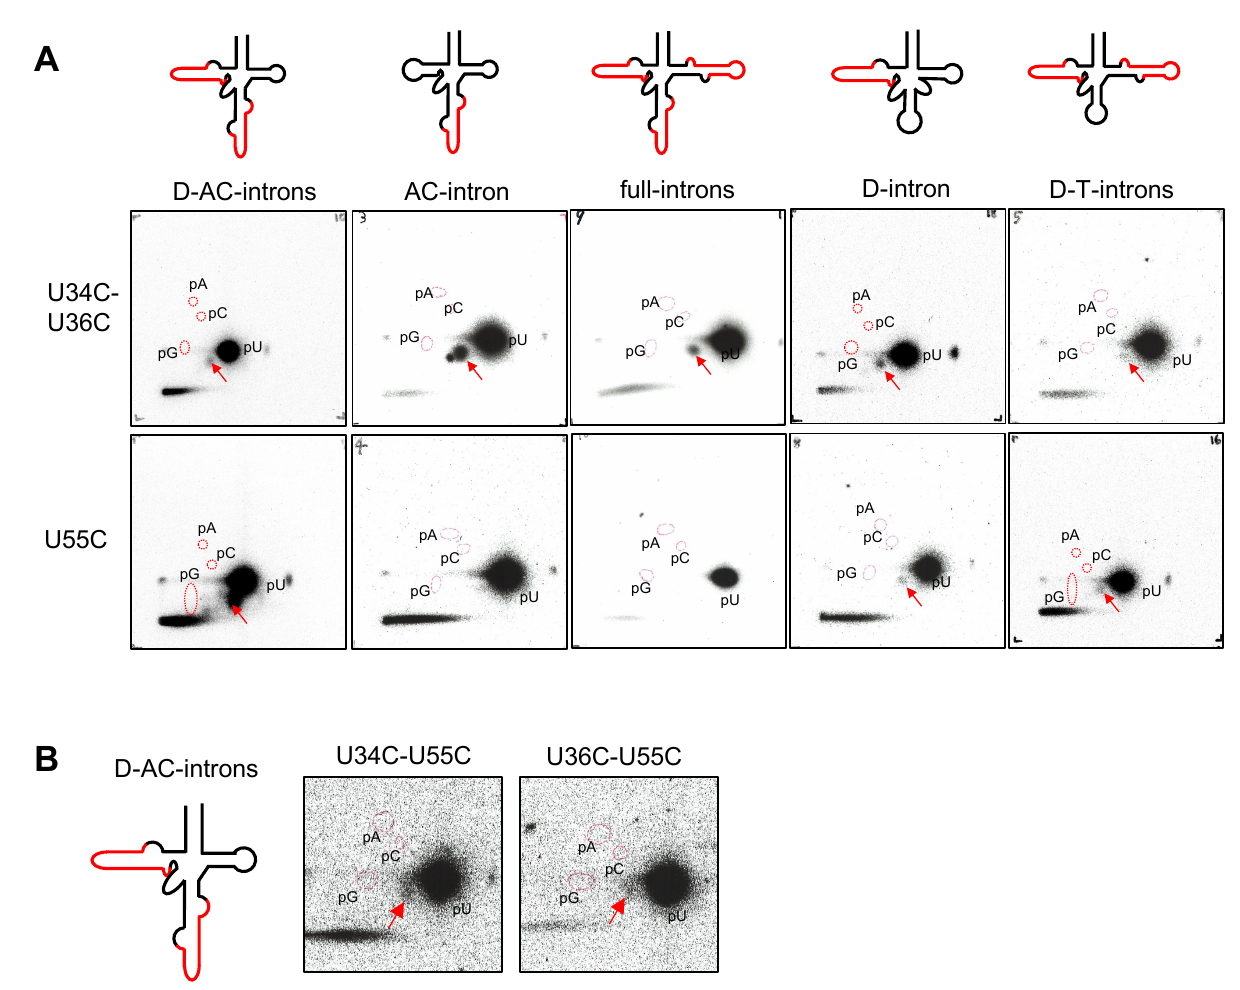
Figure 5. In vitro pseudouridylation activities of cmPus1 towards pre-tRNA Ile (UAU) mutants. Spots derived from p Ψ are indicated by red arrows. ( A ) The α - 32 P-UTP-labeled pre-tRNA Ile (UAU) mutant was incubated with cmPus1, and Ψ formation analyzed by 2D-TLC. ( B ) In pre-tRNA Ile (UAU)